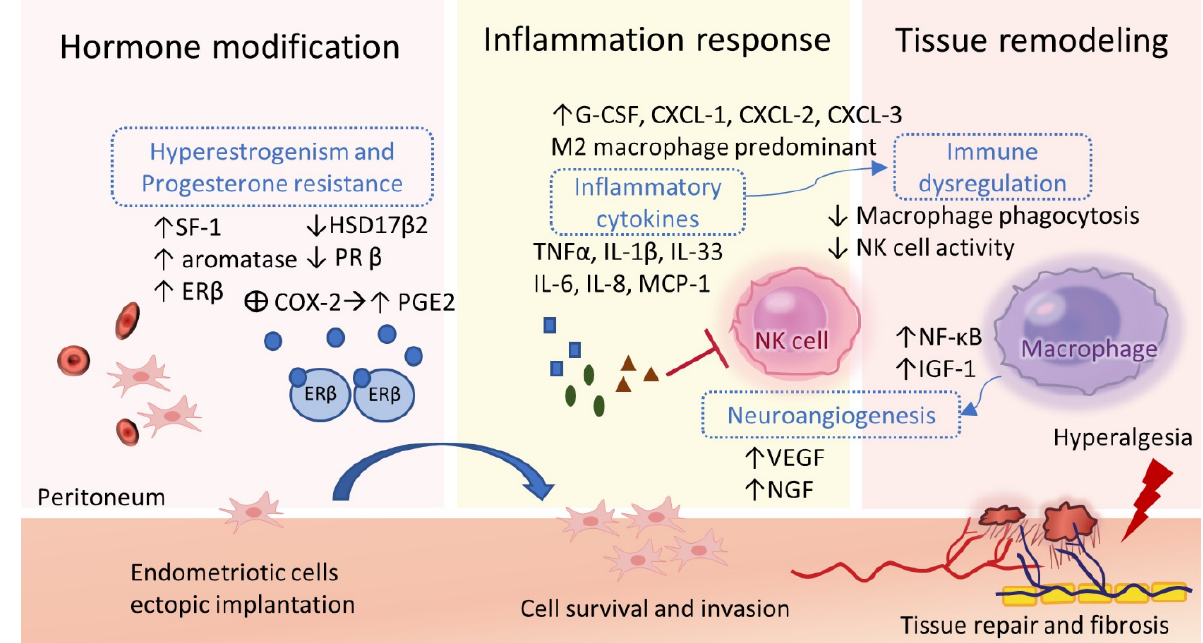
Figure 2. Pathophysiological processes of endometriosis. Endometriotic lesions are established through interacting molecular mechanisms in a micro-environment of hyperestrogenism and pro- gesterone resistance that promote cell survival and invasion, systemic and localized steroidogenesis, inflammatory response, immune dysregulation, and neuro-angiogenesis. The upward arrows rep- resent overexpression; the downward arrows represent down-regulation.